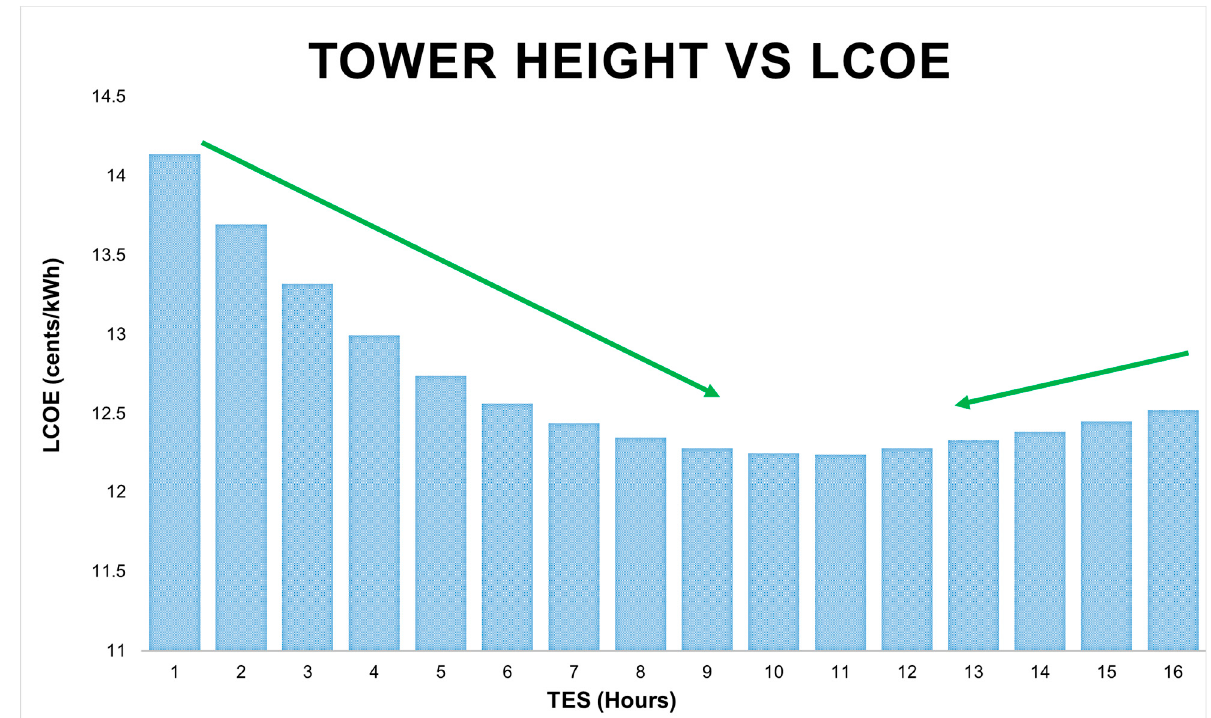
Figure 16. Tower height comparison results.